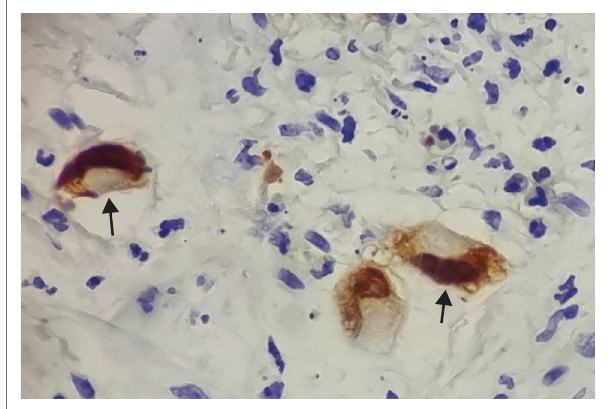
FIGURE 2: Immunohistochemistry for cytomegalovirus (at × 40 magnification) demonstrating intra-nuclear inclusions (black